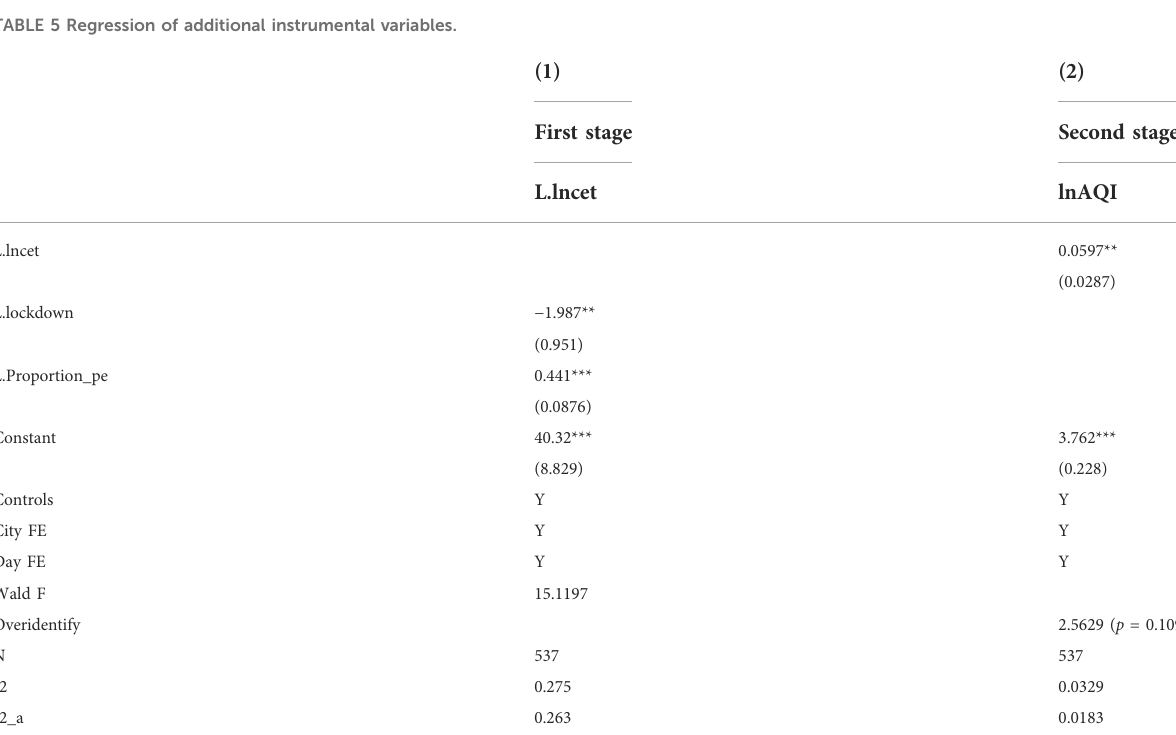
TABLE 5 Regression of additional instrumental